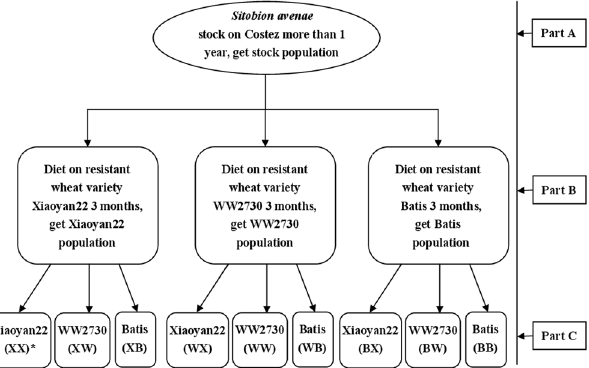
Figure 1. This figure show how the English grain aphid Sitobion avenae , were derived and how the three host- adapted strains were generated. Note: “ * ” The first capital letters in the brackets represented the acclimatized population (or conditioning wheat variety), and the second represented the transferred transition wheat